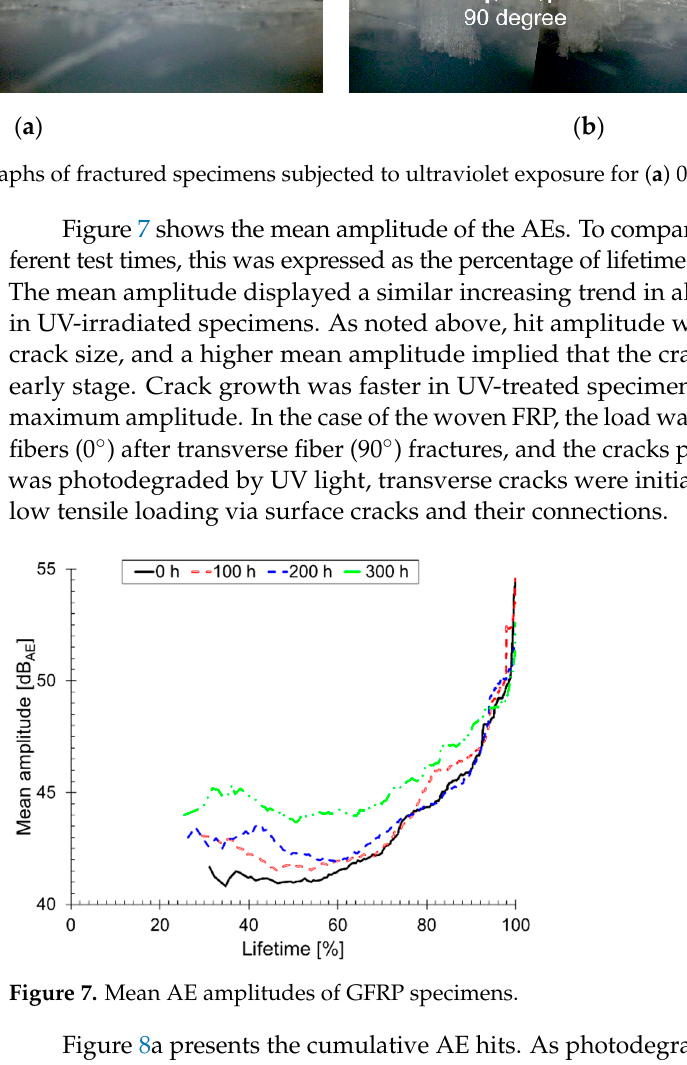
( b ) Figure 8. Acoustic emission (AE) hit distribution. ( a ) Cumulative AE hits and ( b ) AE occurrence rate (hits per second) for the 0 h specimen. 3.2. Structural Health Monitoring via Ib-Value Analysis As discussed in the previous section, the I b -value can be used to diagnose the state of the structure by determining the frequency at which a higher-amplitude signal appears as a result of crack propagation. Figure 9 presents an example of an amplitude distribution and I b -value calculation for a 0 h specimen. Labels #1–4 are the same as those in Figure 8b. Amplitudes were calculated based on I b -values within a specific range around the mean value (a 1 = 10, a 2 = 5). The I b -values continuously decrease, unlike the b -value. Our previous b -value analysis of a GFRP [30] determined that increasing b -values stem from the complex failure behavior of FRP, which creates many microcracks, even when they are propagating. Hence, the I b -value is more suitable than the b -value for SHM of FRP structures. Figure 10 shows the I b -values over the lifetime of the specimens. The parametric val- ues were calculated after successive generation of 10 AE hits (e.g., 1st–10th, 1st–20th …1st–100th). The I b -values continued to linearly decrease until the end of the experiment. The maximum I b -value in the experiment corresponded to the beginning of crack growth, and the minimum value corresponded to specimen failure. The trends were quite similar between the 0 and 100 h specimens, but the starting I b -value was lower for the 200 and 300 h specimens. Notably, the I b -value behavior of all specimens linearly decreased and